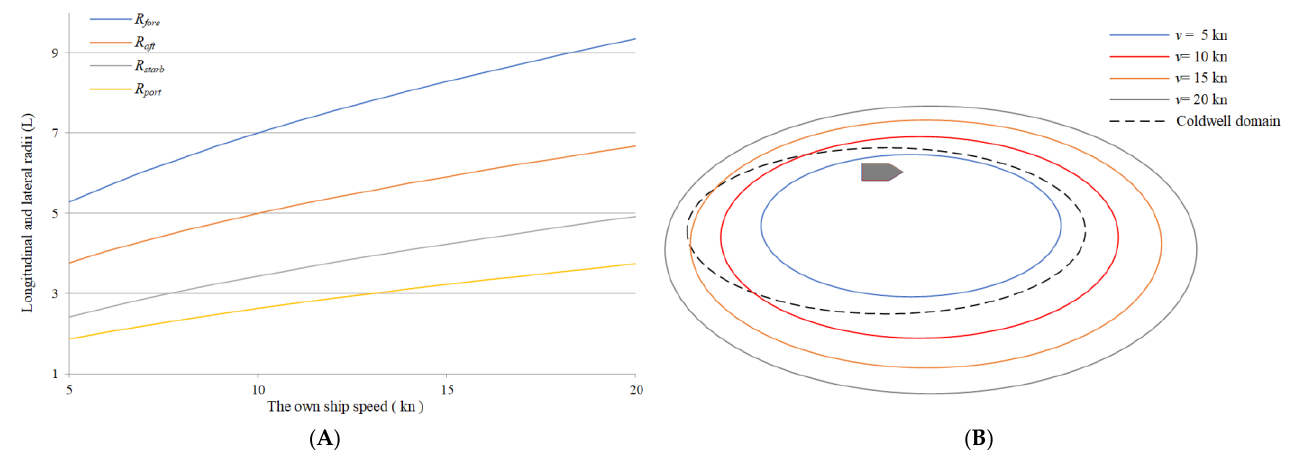
Figure 6. ( A ) The radii of the elliptical dynamic ship domain for various ship speeds; ( B ) combined elliptical dynamic ship domain and Coldwell domain.